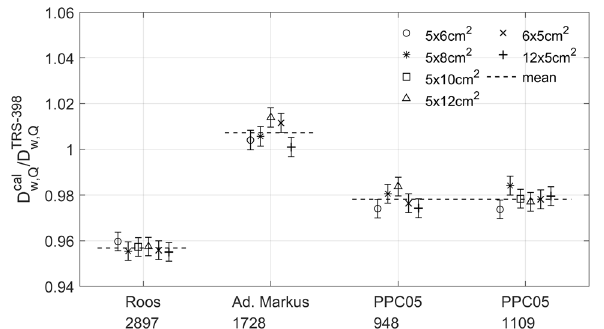
Figure 4. Ratio between the dose determined by the NPL PSPC and the dose derived from ionisation chambers for the various fields tested. The dashed lines represent the mean ratio value for each ionisation chamber type and the error bars represent type A standard